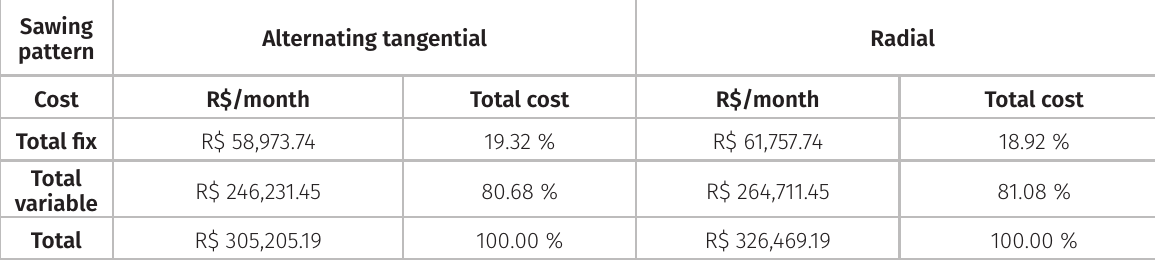
Table I. Total fix costs, total variable cost and total cost for the alternating sawing pattern and radial sawing